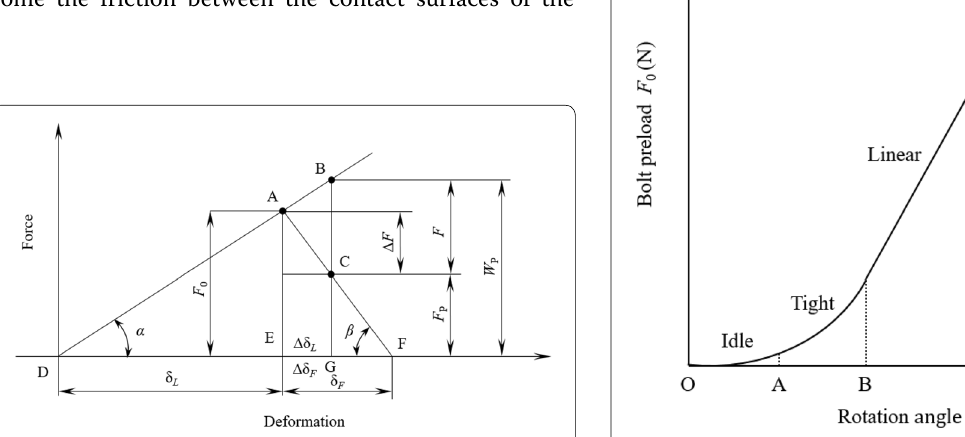
Figure 5 Relationship between bolt preload and rotation angle